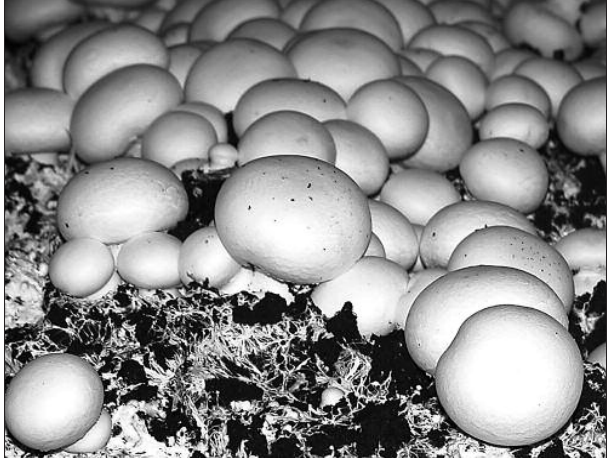
Figure 1. Fruit bodies of white button mushroom (Agaricus